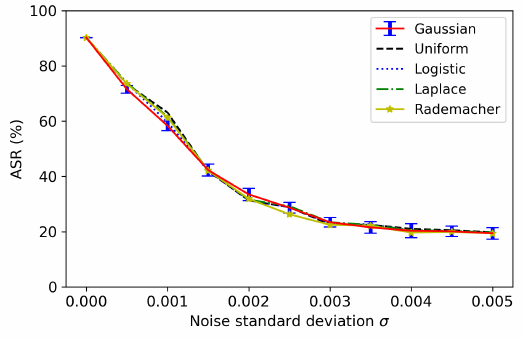
Figure 9. Performance of the noise-adding defense with different types of noise on FakeBob adver- sarial audios in GMM SV